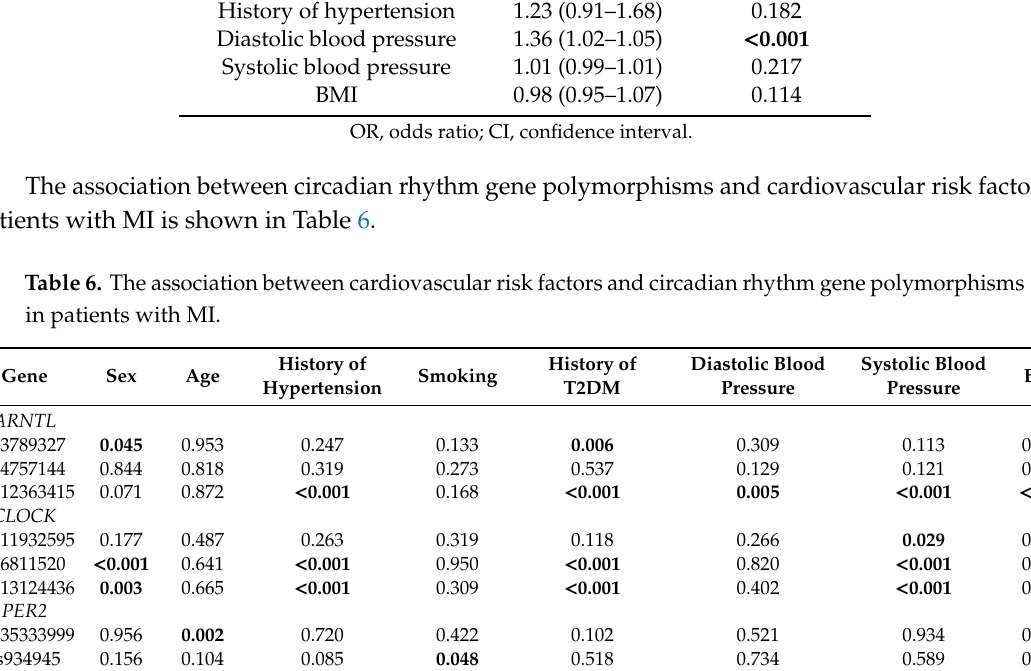
Table 5. Odds ratios for myocardial infarction adjusted for cardiovascular risk factors included in the logistic regression model. Risk Factor OR (95% CI) p -Value Age 0.96 (0.95–0.97) History of hypertension